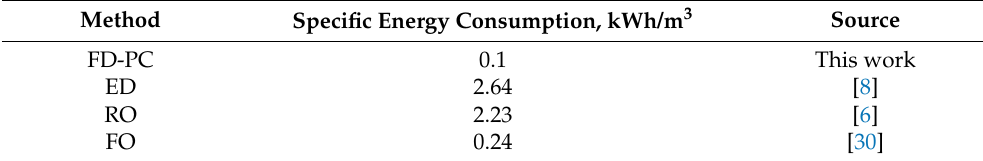
Table 3. Comparison of specific energy consumption for common methods of water